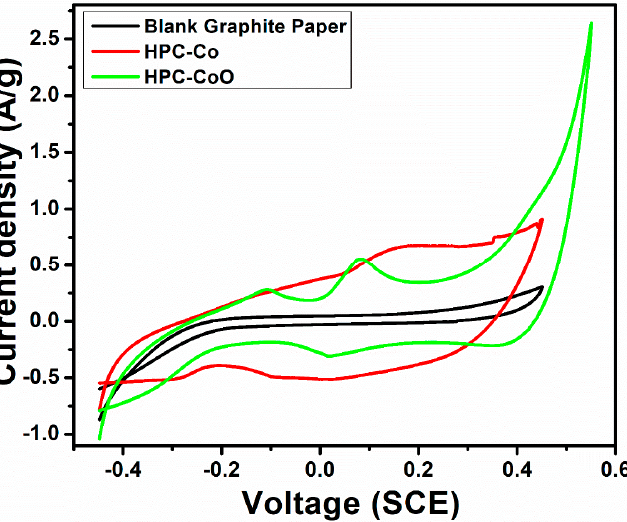
Figure 14. Cyclic voltammetry plot of modified graphite paper with HPC-Co (1), showing semi- rectangular shape indicating a perfect capacitive behavior. For HPC-CoO (2) sample, the modification in oxidation/reduction peaks was evident.